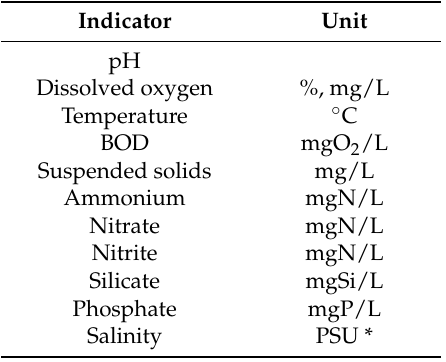
Table 3. Measured physical-chemical variables.